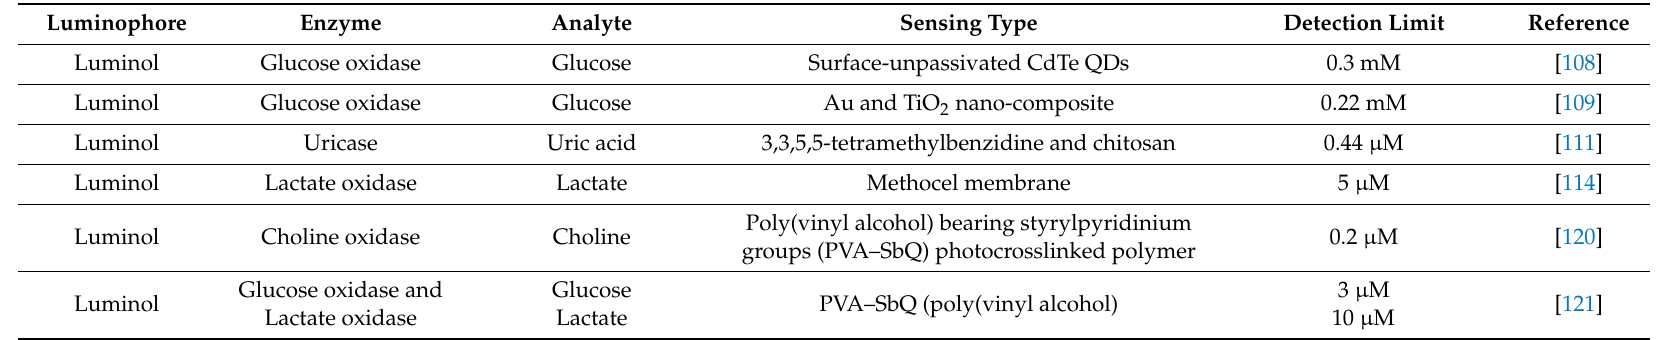
Table 2. Analytical parameters of SPE-based ECL enzymatic